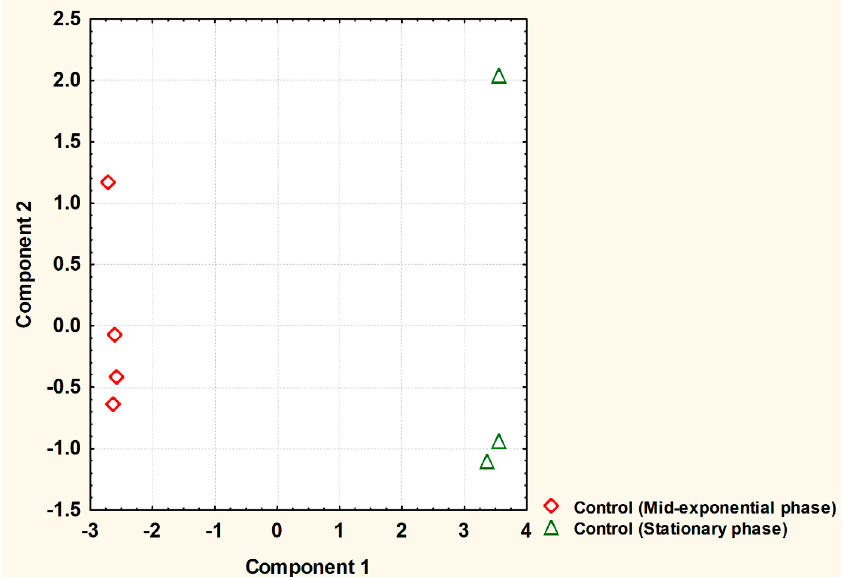
Fig. 2. The principal component analysis (PCA) of S. aureus cytoplasmic metabolite profiles derived from cells grown to mid-exponential and stationary phases under normal